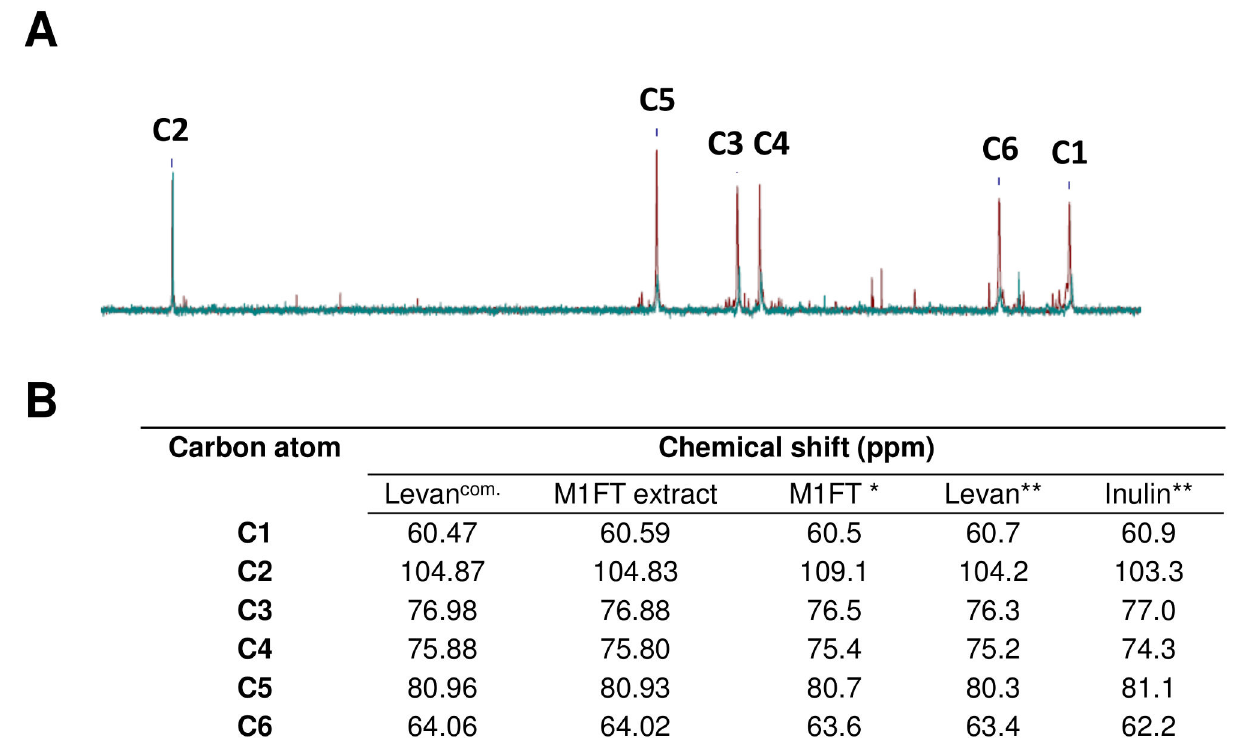
Figure 3. 13 C-NMR analysis of the fructan polymer produced by M1FT. (A) Overlay of the 13 C-NMR spectra from the M1FT produced polymer and a commercially available levan polymer from Zymomonas mobilis . (B) Comparison of the chemical shifts for the levan polymer from Zymomonas mobilis (Levan com. ); M1FT, the polymer produced by M1FT in this study; M1FT*, previously described by Kang and colleagues [24]; Levan** and Inulin**, previously described by Shimamura and colleagues [20]. doi: